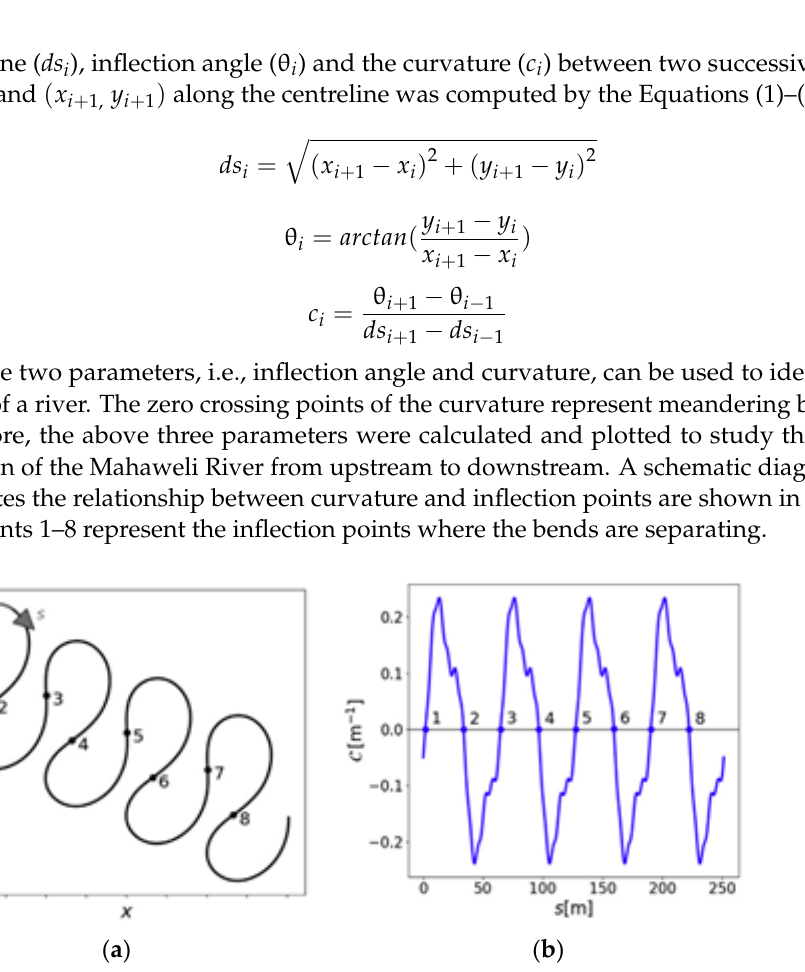
Figure 4. Schematic diagram of bend separation using curvature of the channel: ( a ) Bends; ( b ) inflection points [8].